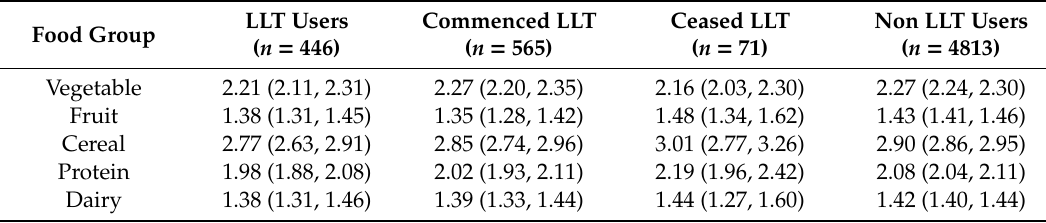
Table 3. Adjusted total serves per day at follow up of key food groups by LLT status, median (95% CI). Food Group